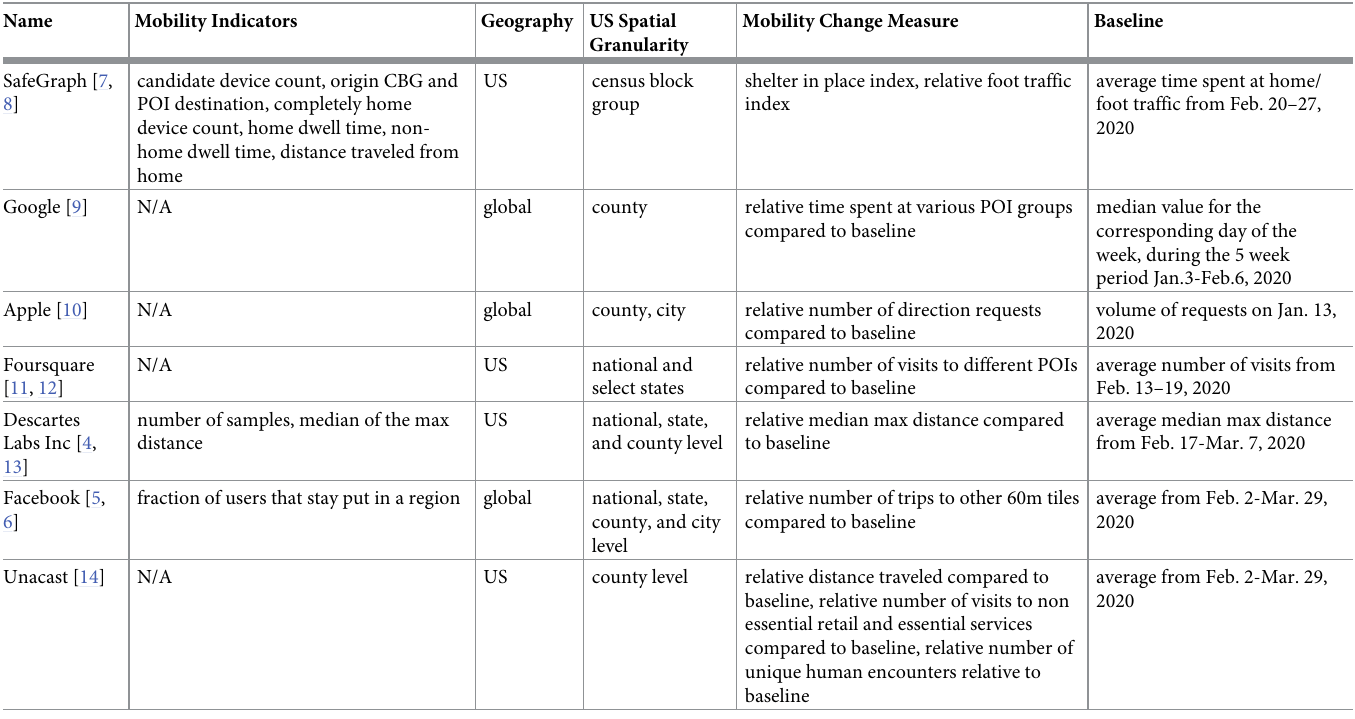
Table 1. Publicly available mobility indicators and mobility change